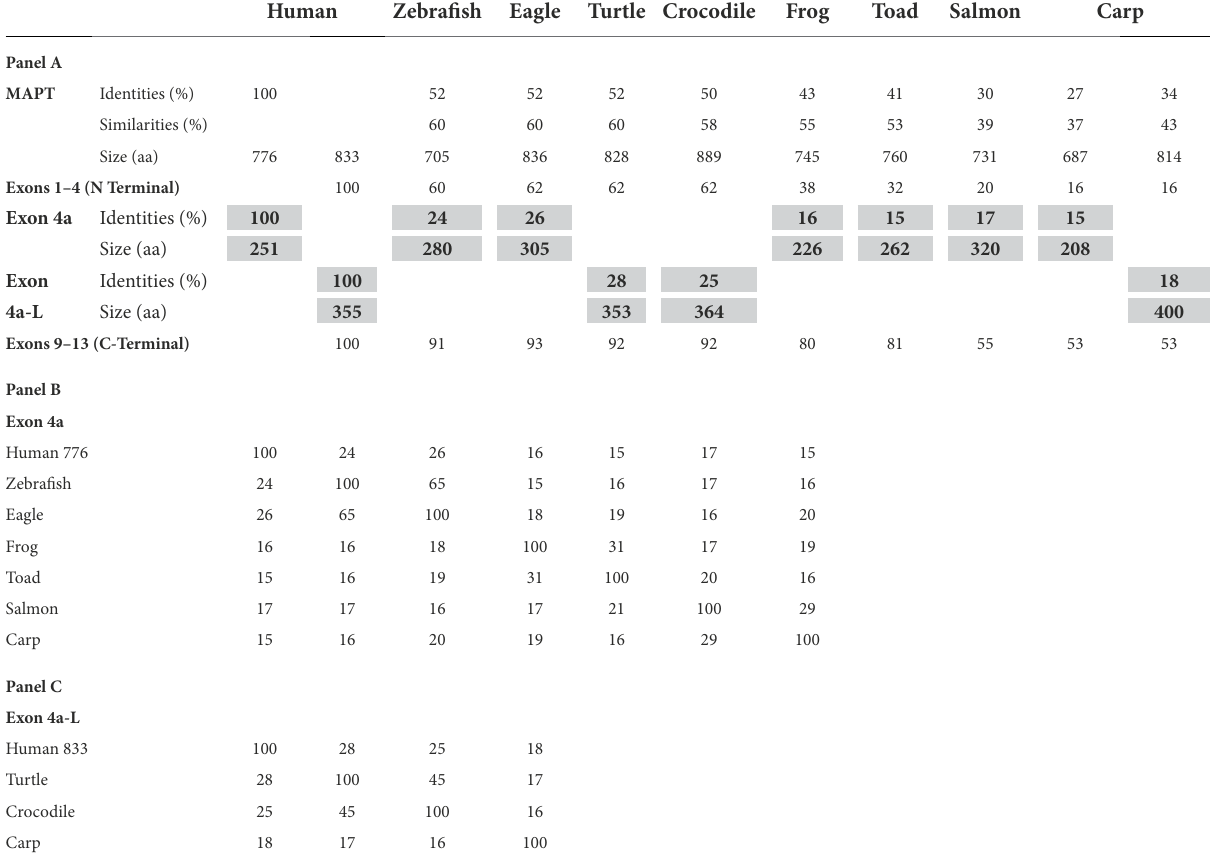
Panel A: MAPT sequence homology was analyzed against human (776aa and 833aa) for cat (778aa), zebra finch (705aa), eagle (836aa), turtle (828aa), crocodile (889aa), frog (745aa), toad (760aa), salmon (731aa), and carp (687aa and 814aa3) all taken from the database presented in Supplementary Figure 1. It included homology (identity and similarity) for the complete MAPT sequence relative to human MAPT, exons 1–4 representing the N-terminal, exon 4a, exon4a-L and exons 9–13 representing the C-terminal including the MTBD. Panel B: matrix identity for exon 4a. Panel C: matrix identity for exon